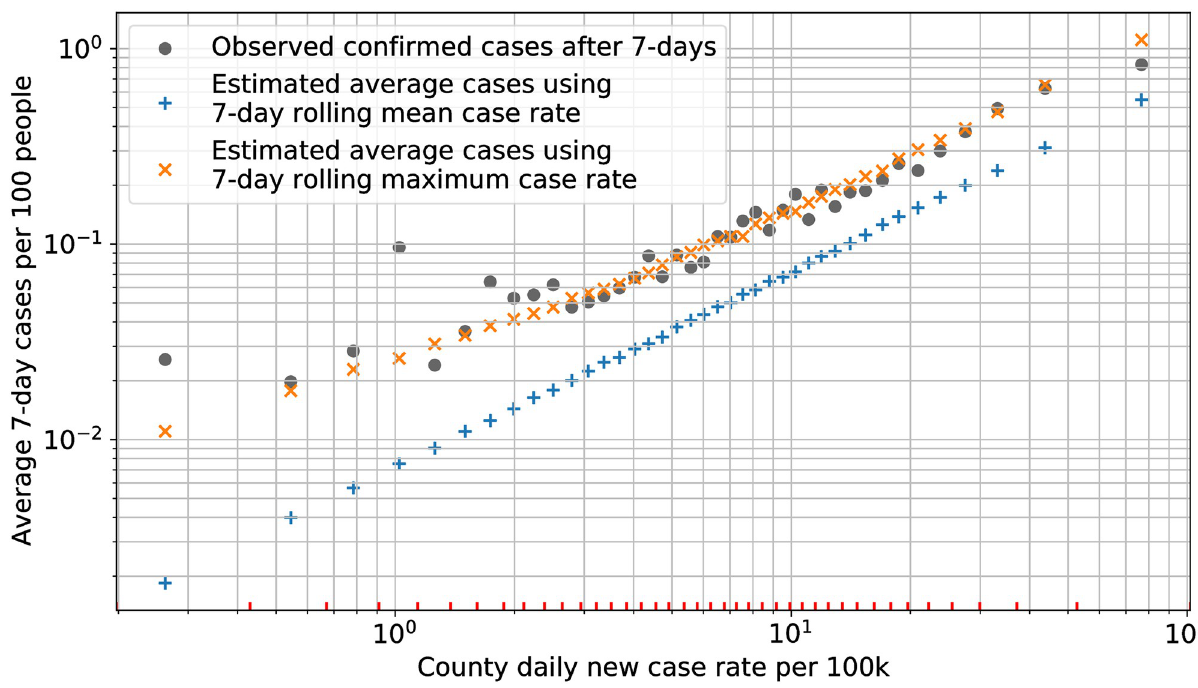
Fig 3. Average 7-day cumulative incidence. Comparison of average confirmed cases in nursing homes prior to and including the week of case introduction, with the model estimates of average cases in 1 week. The red ticks on the x-axis mark the 7-day mean case-rate boundaries of each category